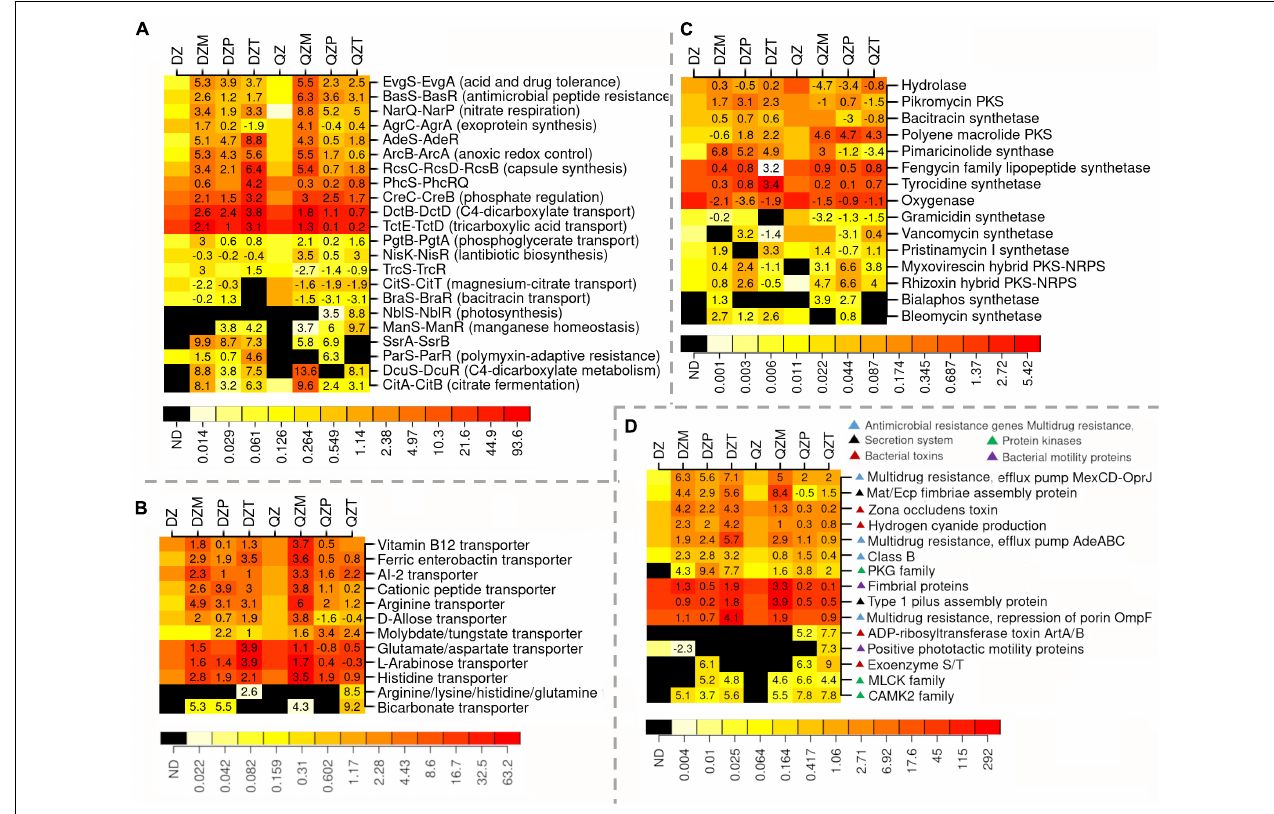
FIGURE 4 | Functional properties selected for and against different plants. Two-component systems (A) , transporter (B) , polyketide synthesis (C) , and other subgroups associated with antimicrobial resistance, production of toxins and protein kinases, motility, and secretion system (D) . Different color indicates RPKB values and number in box indicates log2 of the ratios on subgroup abundance between rhizosphere and